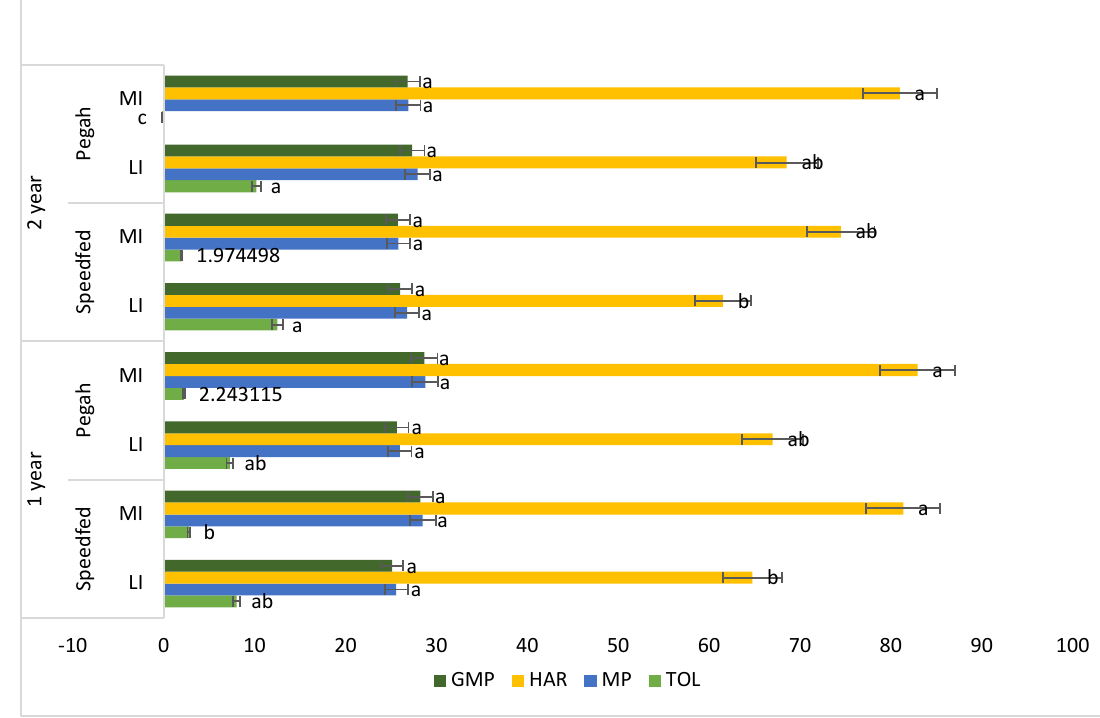
Fig. 3: Values of drought tolerance indices for maize hybrids under different irrigation levels. Different lower-cases for interaction on the bars show significant differences (Duncan, P < 0.05). Medium irrigation (MI) and Low irrigation (LI)